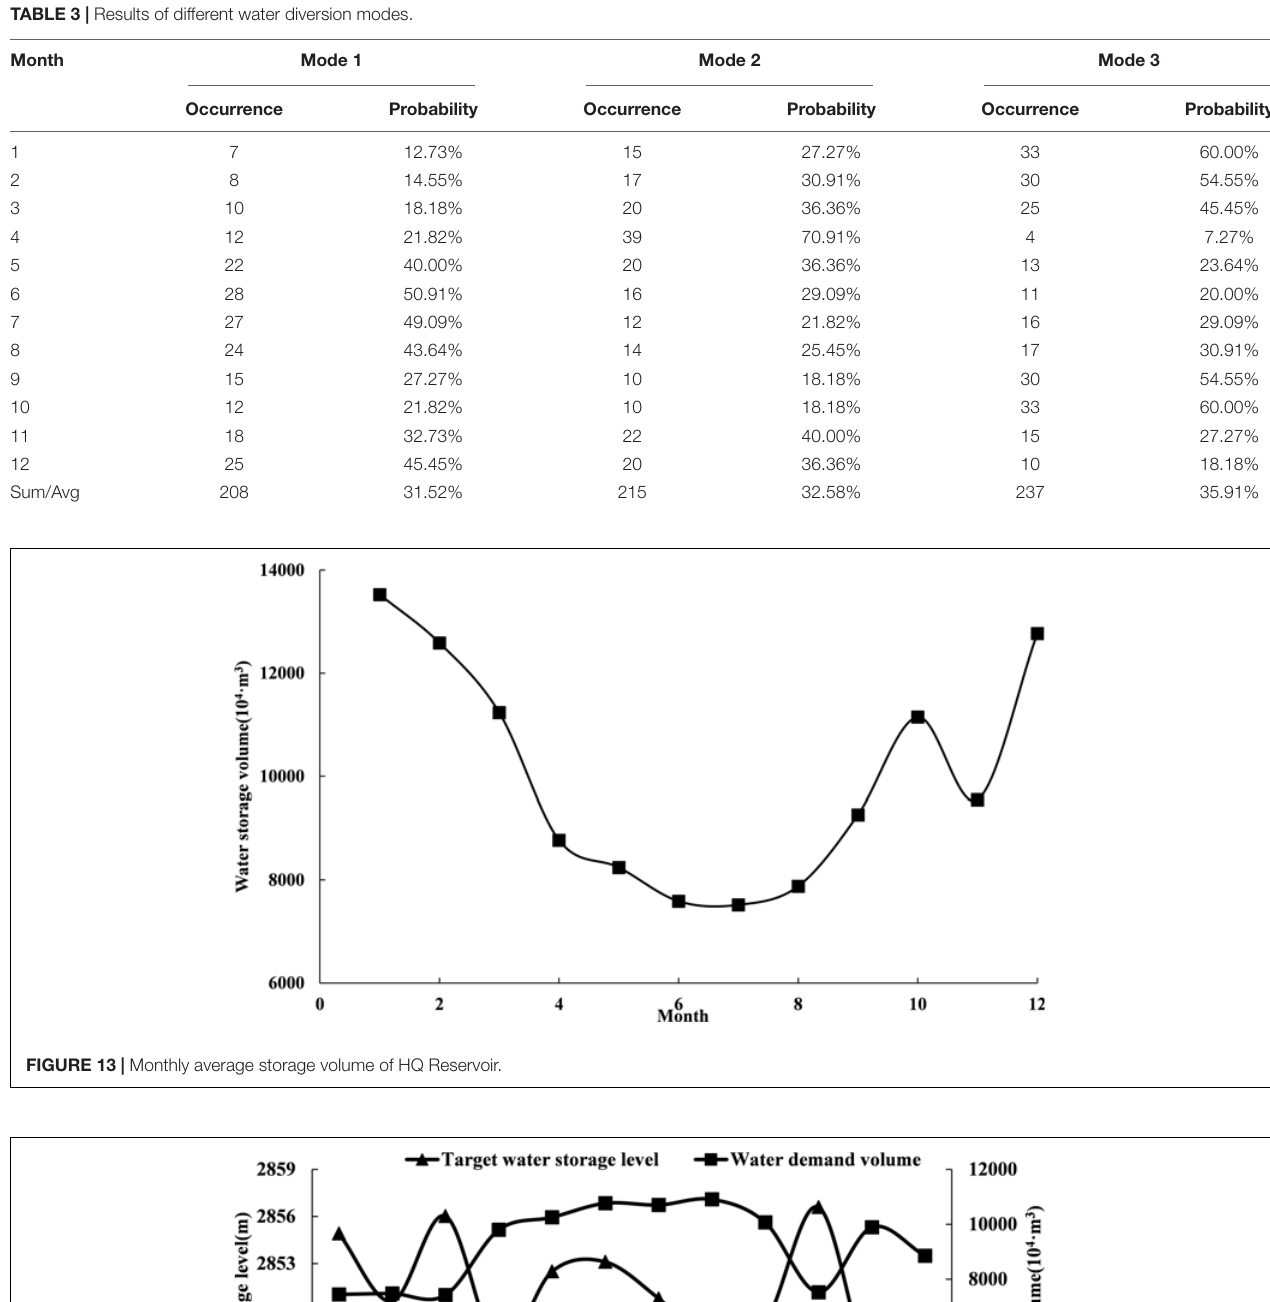
TABLE 3 | Results of different water diversion modes.